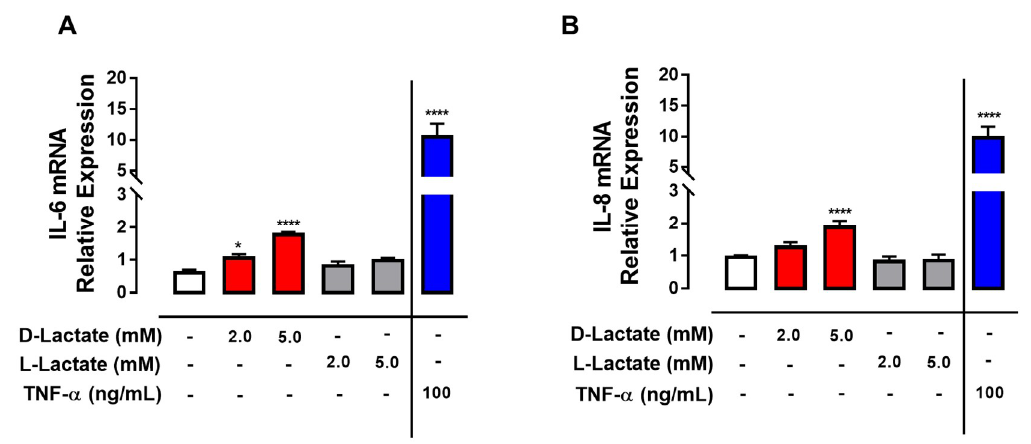
Figure 1. D-lactate increases the expression of IL-6 and IL-8 in bovine fibroblast like synoviocytes (bFLSs). Relative expression of IL-6 ( A ) and IL-8 ( B ) mRNA in bFLS cells treated with D-lactate or L-lactate for 6 h. Bovine tumoral necrosis factor alpha (bTNF-α) was used as a positive control. Each bar represents the mean ± standard error of media (SEM). n = 5, * p < 0.05; **** p < 0.0001 compared to